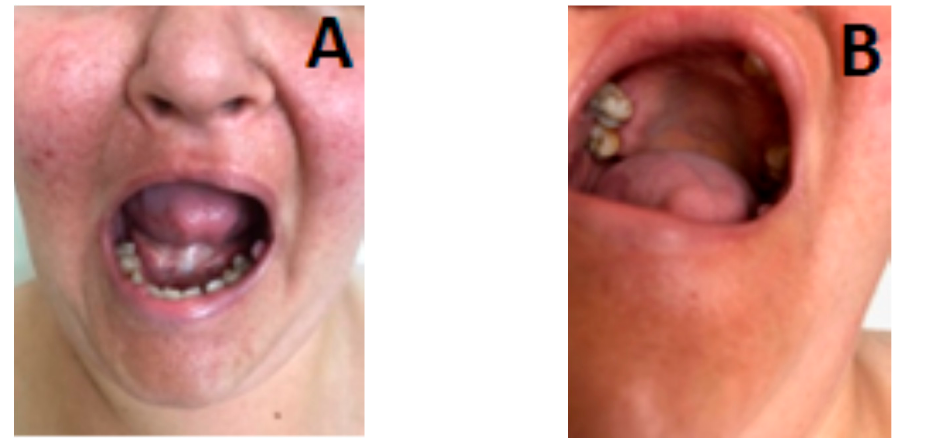
Figure 2. Oro-dental features: ( A ) Dental caries, sublingual fibroma; ( B ) Oligodontia, tooth enamel alteration.